Question: What form of chart is displayed?
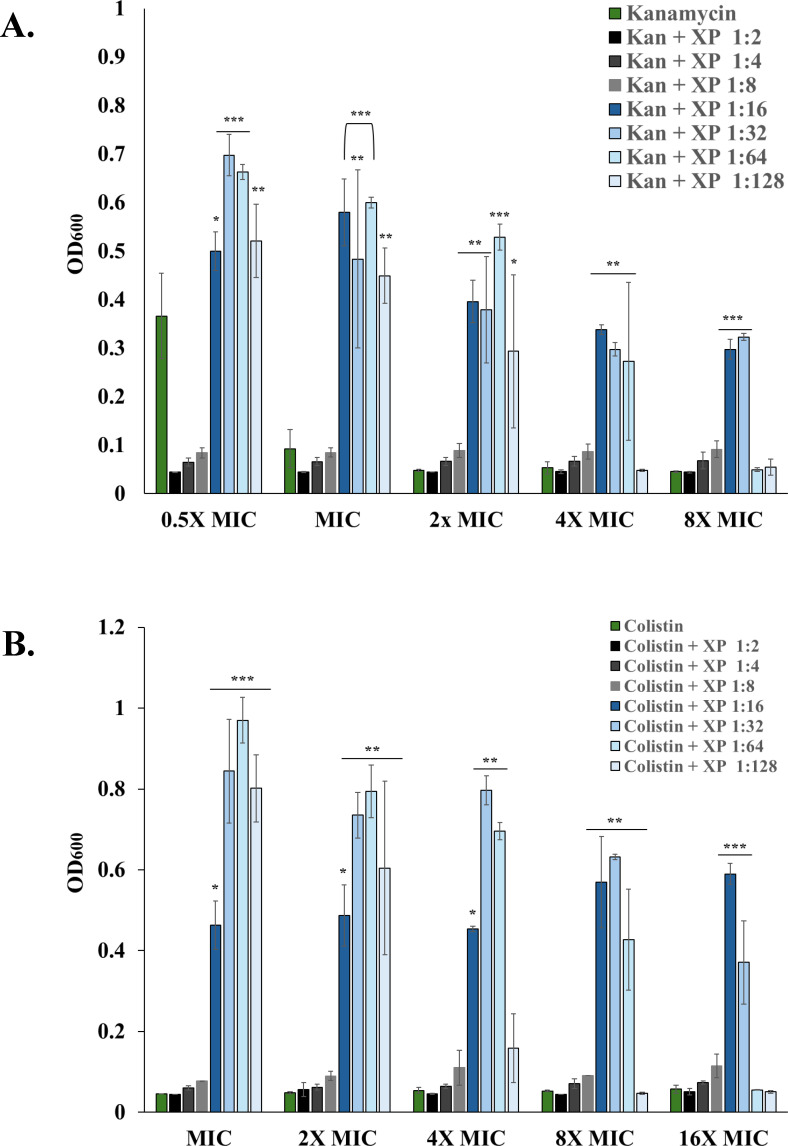
Answer: bar